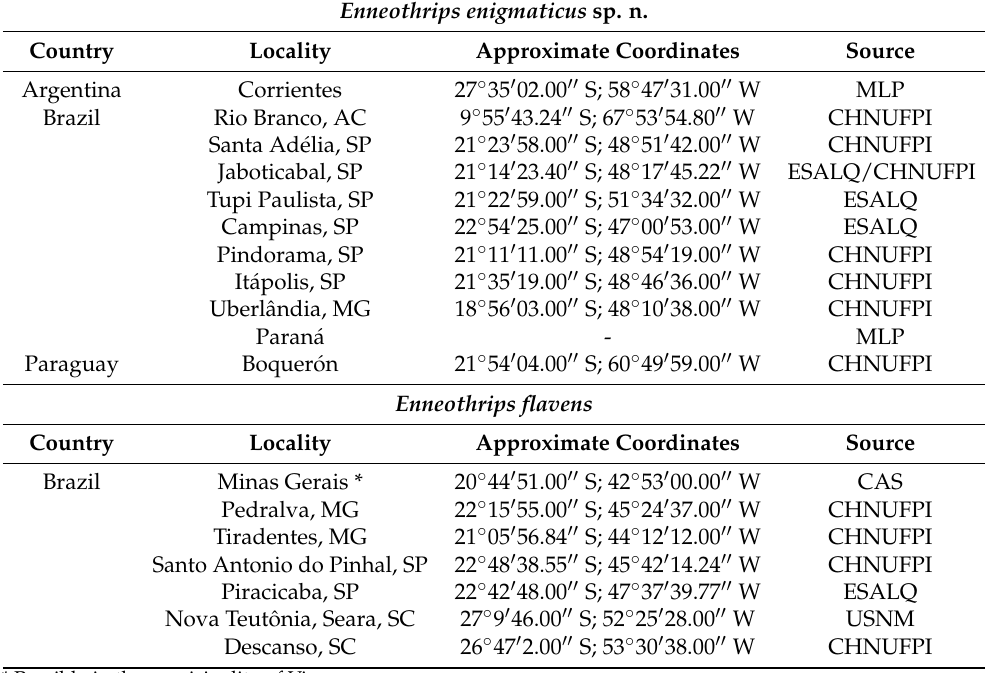
Table 1. Approximate coordinates of reliable available records of Enneothrips enigmaticus sp. n. and Enneothrips flavens in South